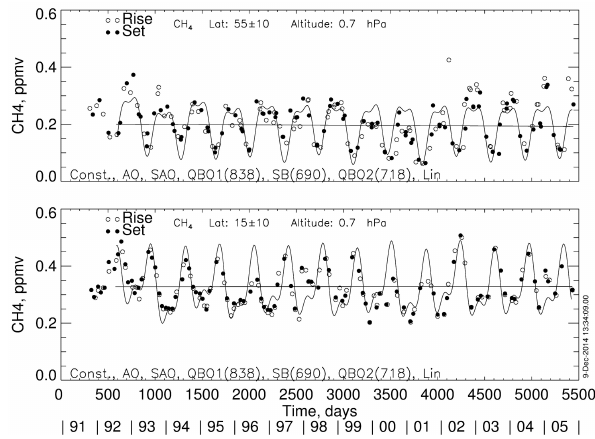
Figure 13. As in Fig. 3, but for CH 4 at 0.7hPa and at the latitudes of 55 ◦ (top) and 15 ◦ (bottom) of the Northern